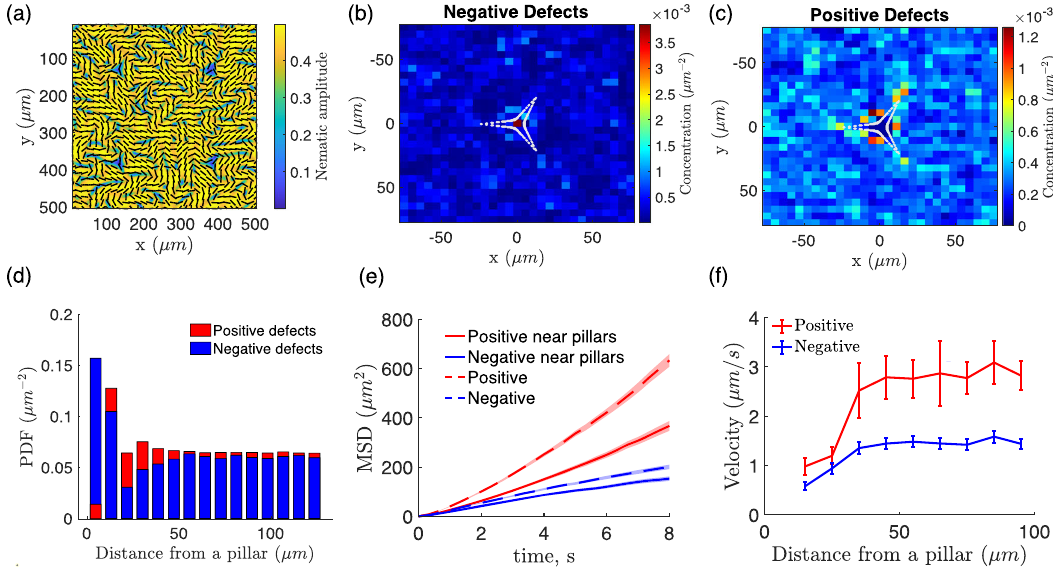
Fig. 4 Simulations of the computational model. a Nematic fi eld around four star-like pillars. Director orientation is shown with thick lines and amplitude of the order parameter with color. The color bar represents the magnitude of the order parameter. Negative ( b ) and positive ( c ) defect concentrations around a pillar. The pillar contour is depicted by white dots. The color bars represents the defect concentrations. d The probability density function of positive and negative defects vs the distance from the pillar center. e MSD vs time for positive and negative defects near pillars (25 μ m < r < 50 μ m) and far from pillars ( r > 140 μ m). Shaded regions represent the standard error of the mean value (SEM), red for positive and blue for negative defects, correspondingly. f Average defect speeds as a function of their average distance to the nearest pillar, calculated for Δ t = 8 s. Error bars show standard deviation. The graininess of b , c is due to the coarse binning of the defect probability densities.